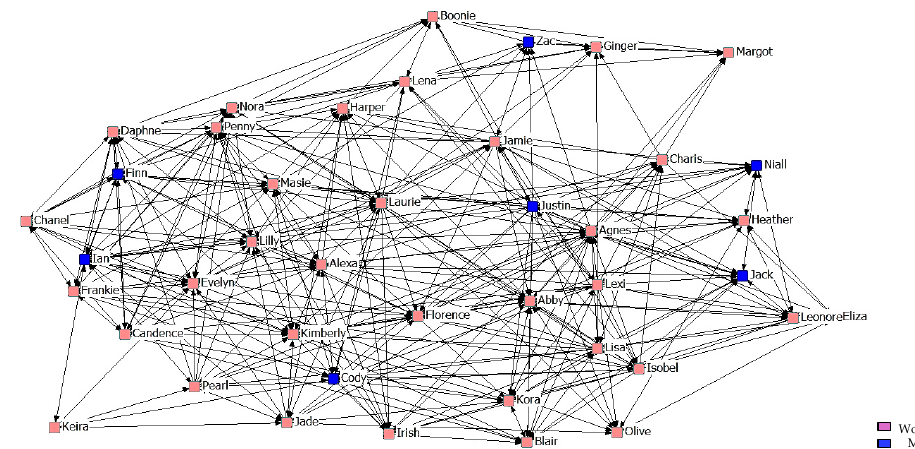
Figure 11. Graph of the third year Intermediate Friendship Network.